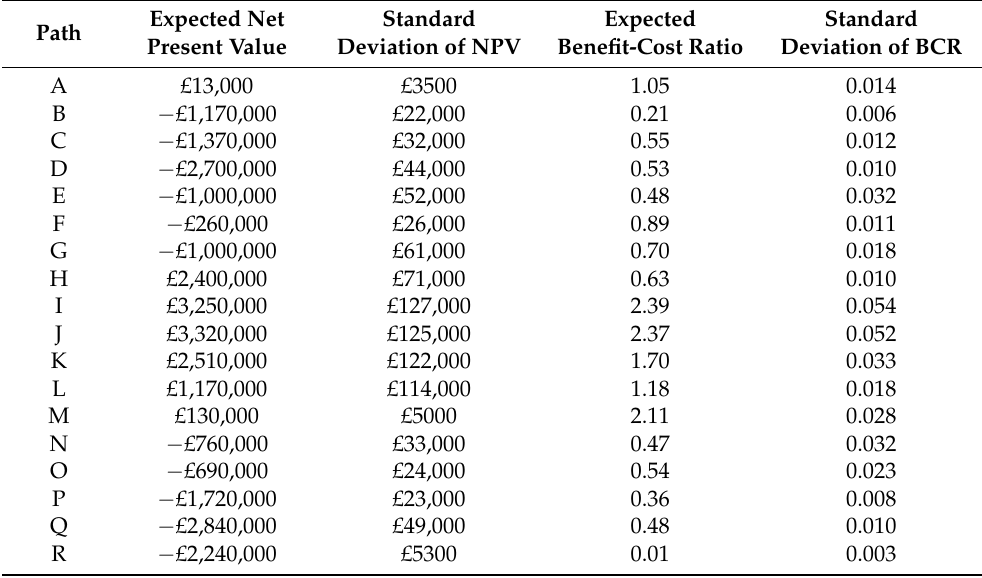
Table 5. Aggregate financial performance of potential paths under